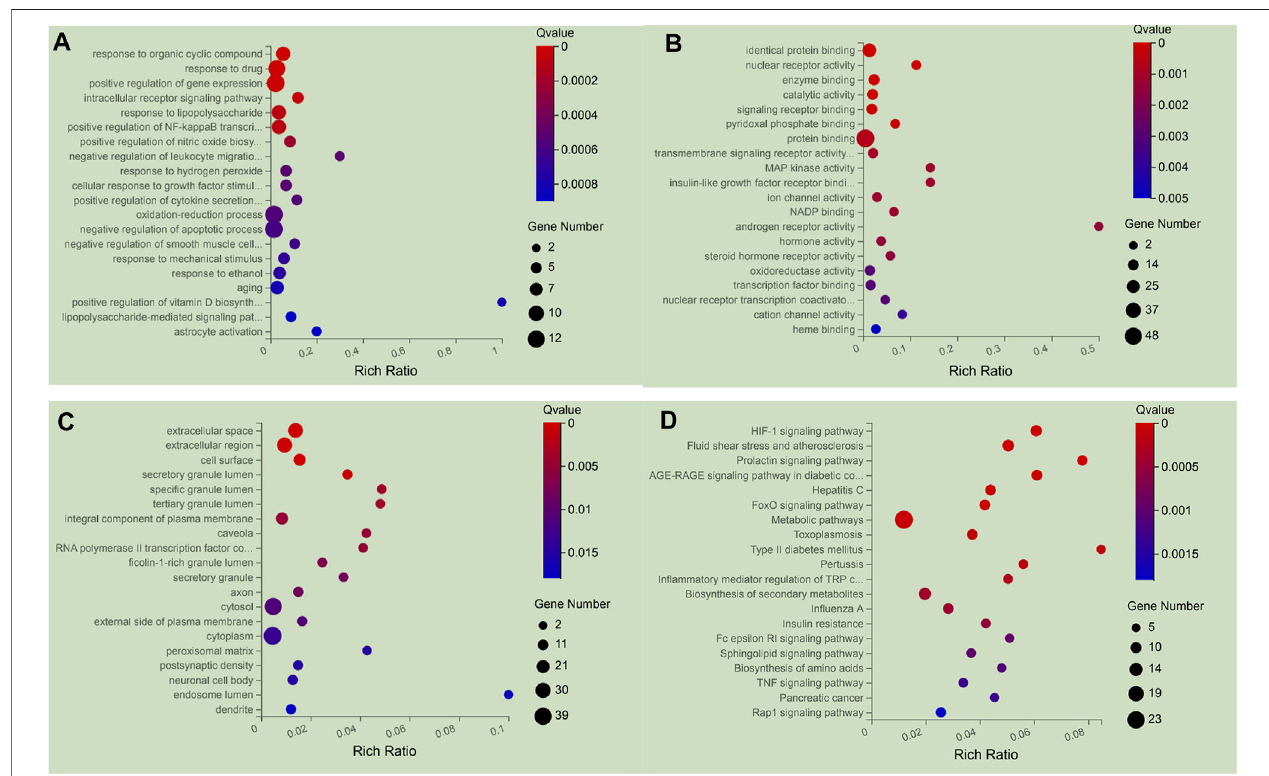
FIGURE9| The20mostsigni fi cancetherapytargetgenesofGOandKEGGpathwayenrichmentanalysisofNFPXonARDS. (A) GOanalysisinbiologicalprocess (BP); (B) GO analysis in molecular function (MF); (C) GO analysis in cellular component (CC). (D) KEGG pathway enrichment analysis.